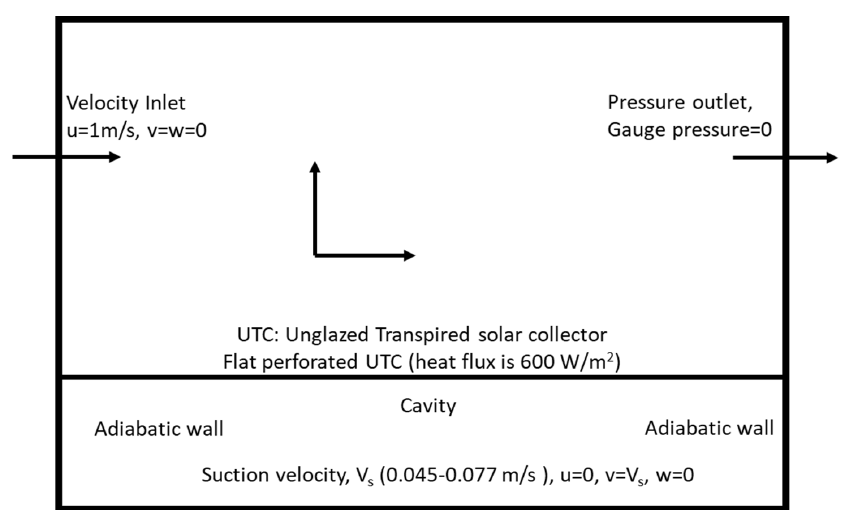
Figure 2. Schematic diagram of boundary conditions for the flow domain in the xy plane.